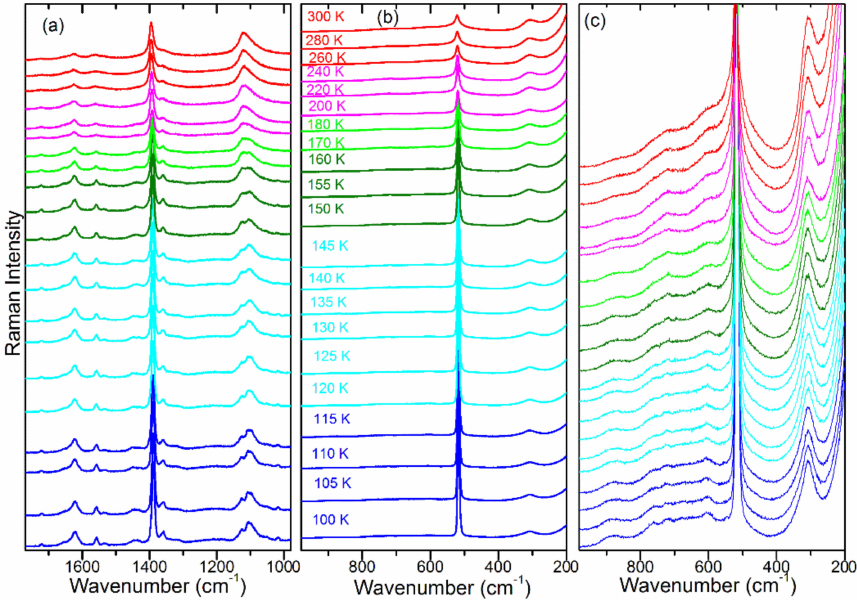
Figure 5. Temperature-dependent Raman spectra of FAPbBr 3 in the ( a ) 1770–980 cm − 1 , ( b ) 980–200 cm − 1 and ( c ) 980–200 cm − 1 range (enlarged compared to panel ( b ) to show weak bands). Red colour corresponds to the Pm 3 m phase; magenta, green and dark green colours correspond to the P 4 /mbm phase; and cyan and blue to the Pnma